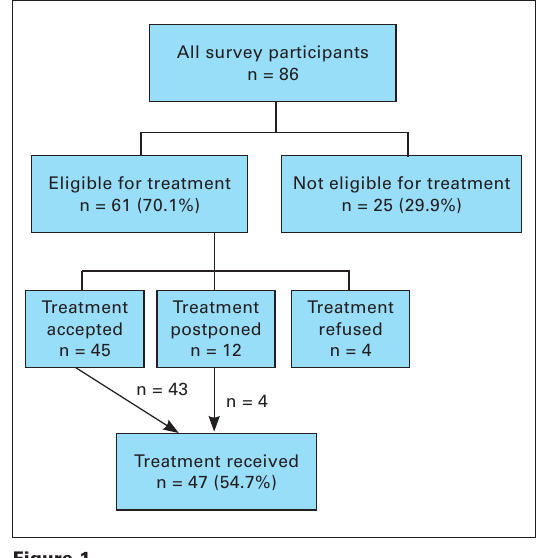
Flow-Chart illustrating antiviral treatment eligibility and prescription rates of survey participants with chronic hepatitis C